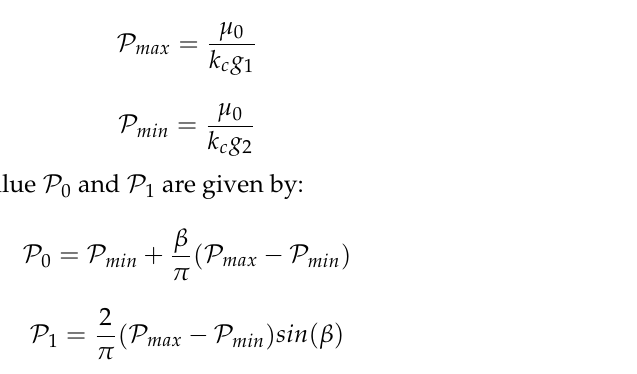
Figure 3. Considering the stator slotting effect, by the use of Carter’s coefficient k c , it can be approximated by the black rectangular function with: